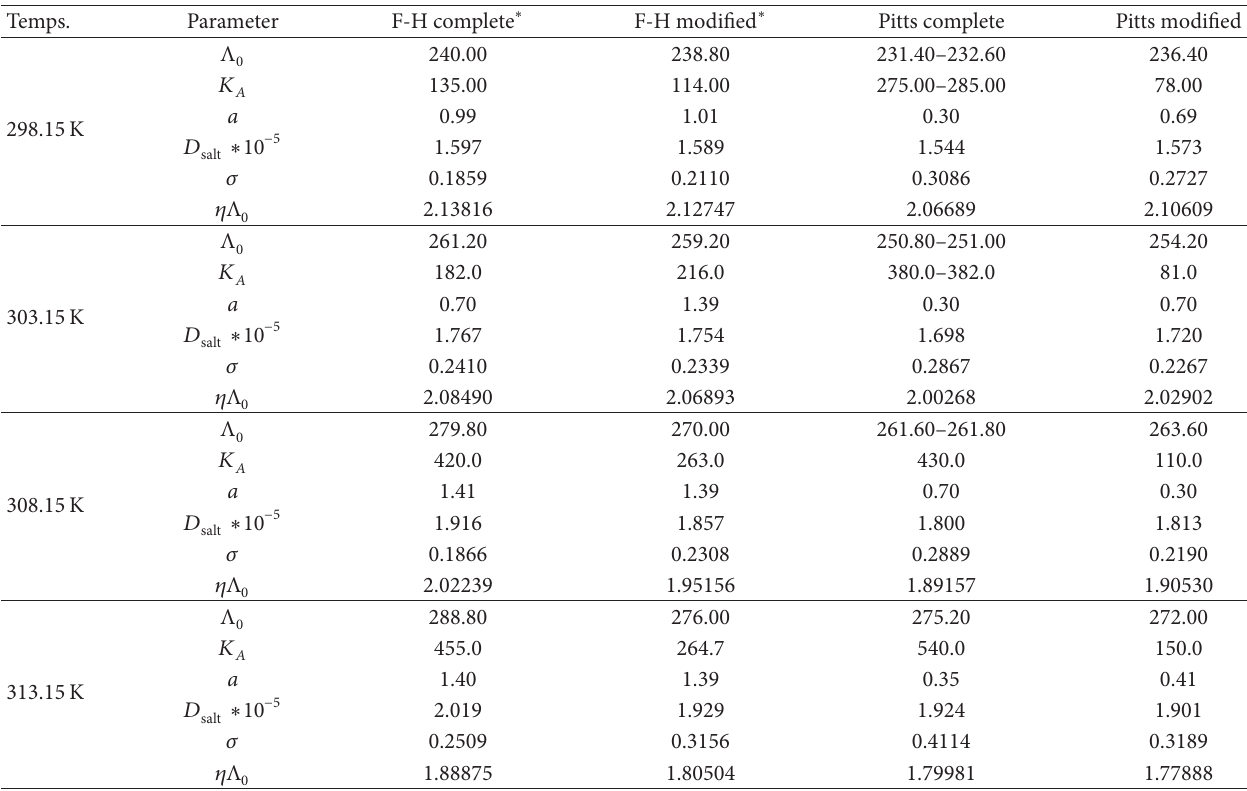
T 5: �est �t results for